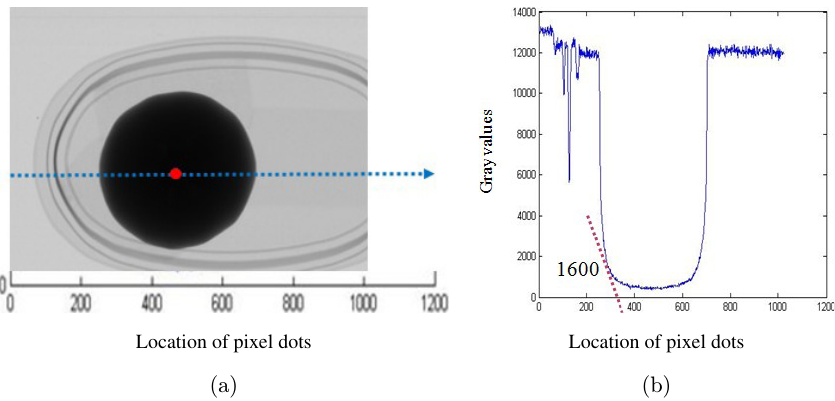
Fig. 5. Original X-ray image of one sample. (a) X-ray image of watermelon and its base; (b) The plot of gray values by intercepting vertical image A across the centroid of watermelon. Table 5. Pearson correlation coe±cient of each two traits.